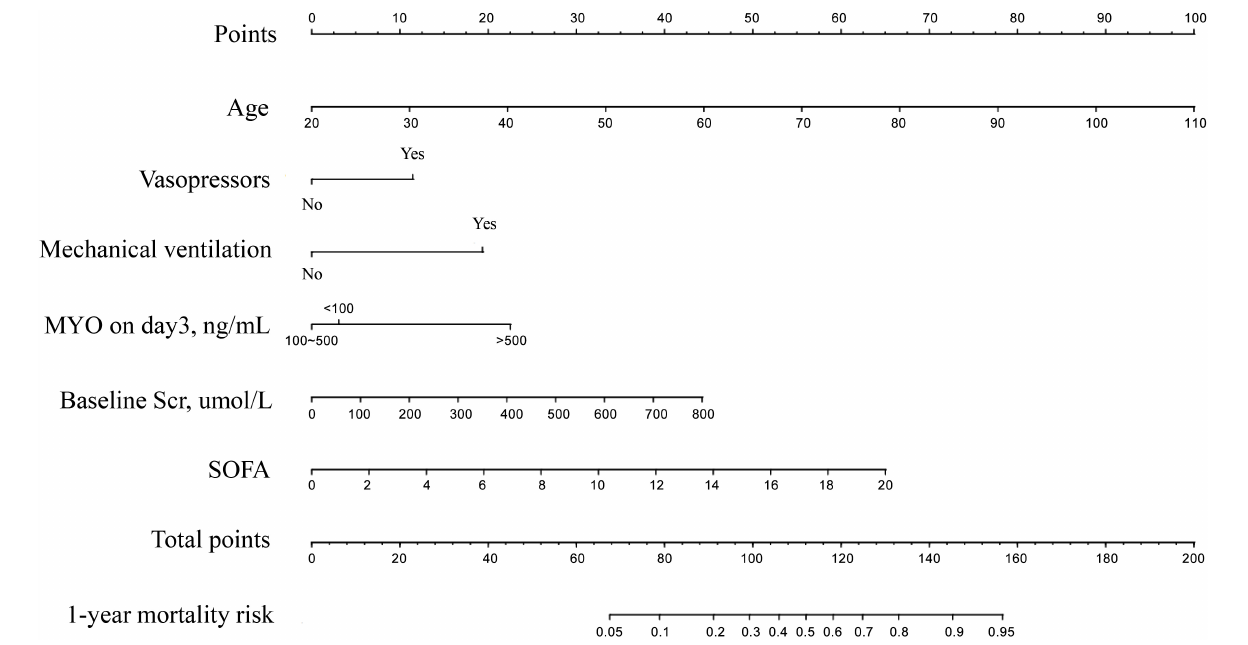
FIGURE 4 | The Nomogram for prediction of 1-year mortality risk in patients with newly diagnosed sepsis-induced cardiorenal syndrome.